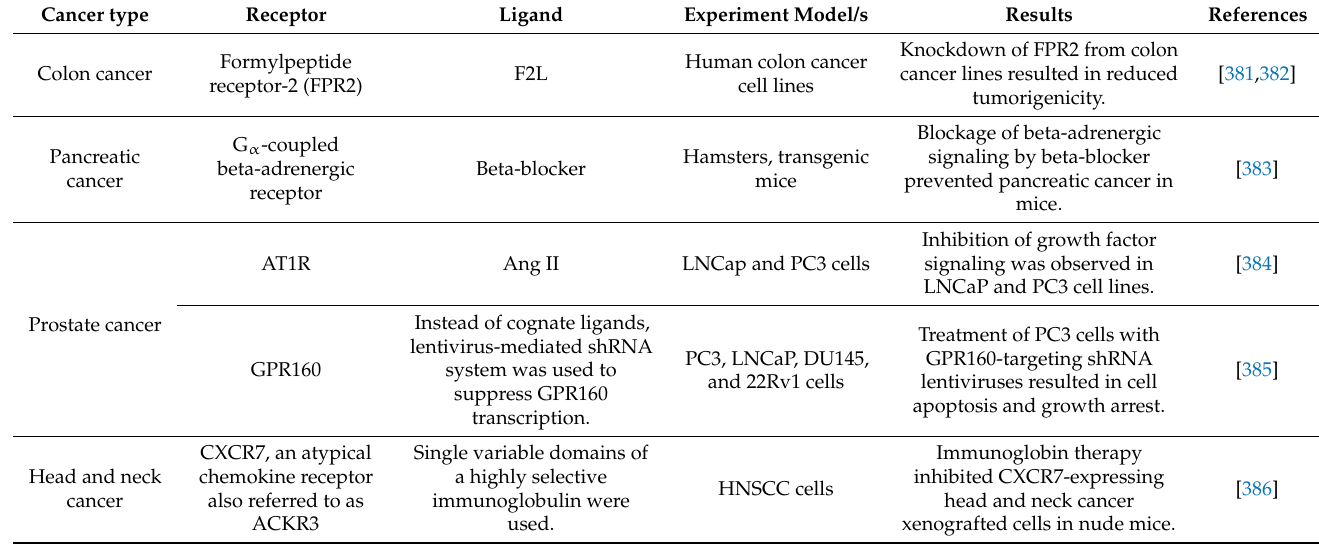
Table 5. Potential GPCR targets for cancer